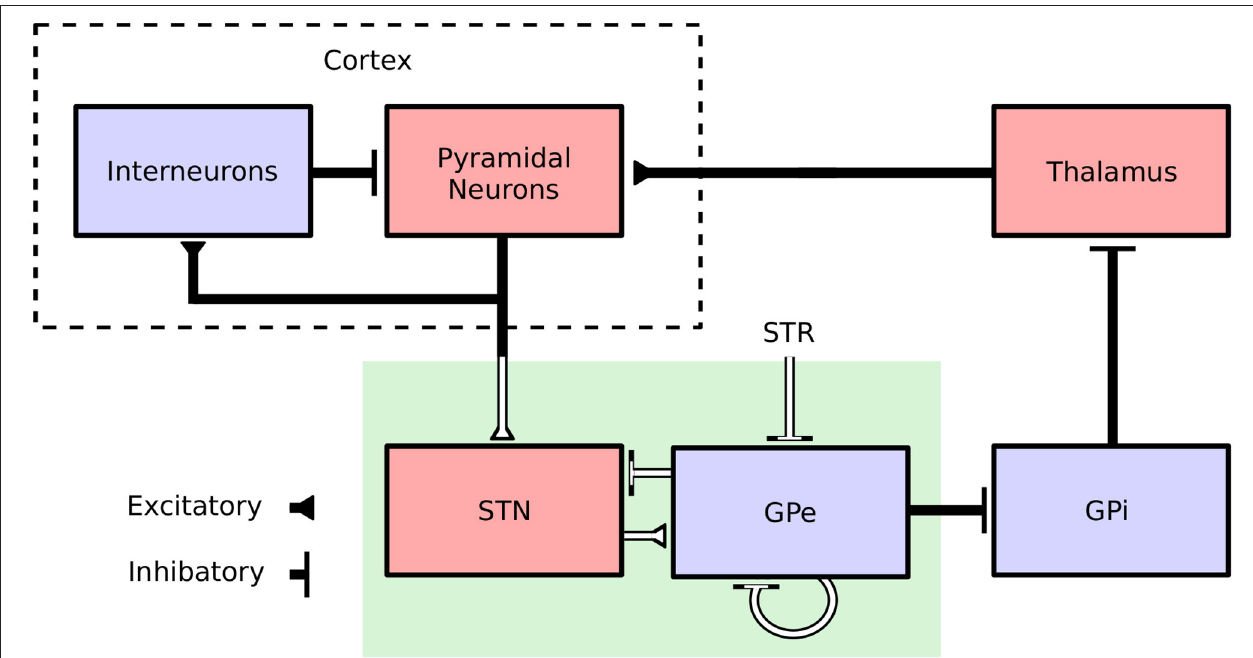
FIGURE 1 | Cortical Basal ganglia network structure. Excitatory and inhibitory populations in the network model are represented in red and blue, respectively. Synaptic connections in the population model are represented by solid black lines. The firing-rate model, representing only a subnetwork of the population model, is highlighted by a green box. White lines correspond to connections which are common to both the population and the firing-rate